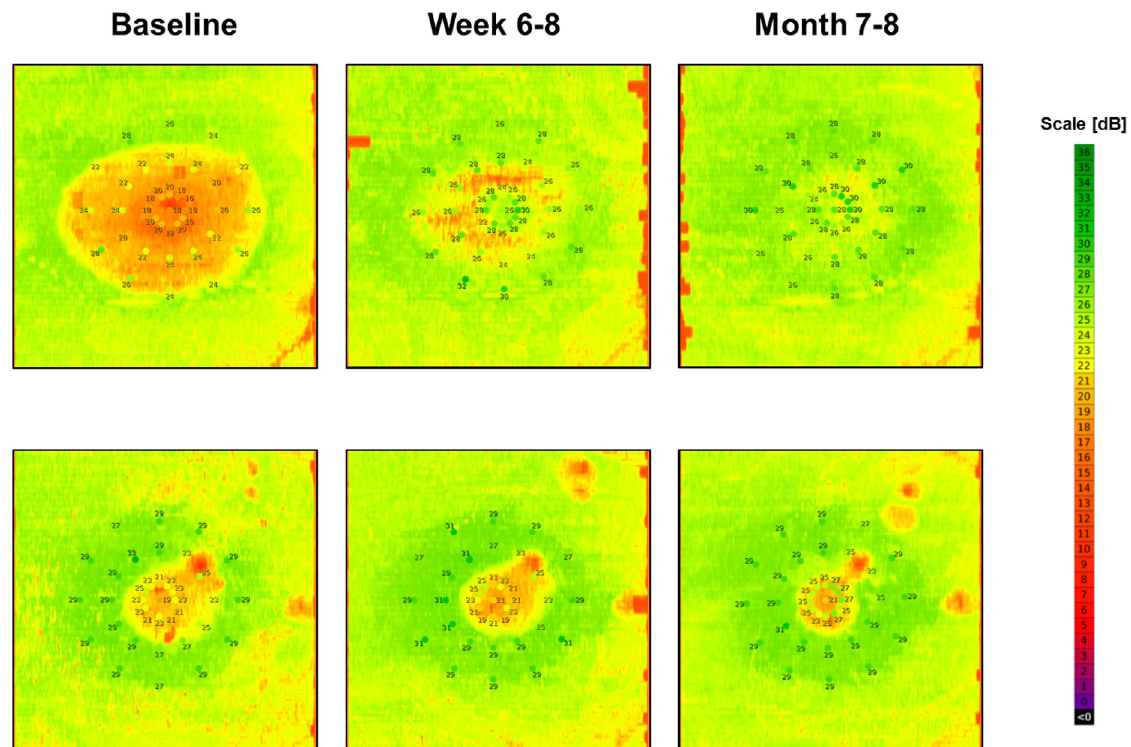
Figure 2. Examples of “inferred sensitivity mapping”. The plots show the cross-validated estimated retinal sensitivity (based on scenario 1) for 3 visits in 2 exemplary patients. The actual fundus-controlled perimetry results are overlayed. The color scale of the device manufacturer was applied for the mapping to facilitate comparisons. Overall, the estimated and observed sensitivity show marked correlation. However, the “inferred sensitivity” maps a superior spatial resolution and coverage of the posterior pole compared to the actual perimetry results. Notably, sensitivity can be estimated for loci between test-points as well as outside of the test pattern. However, the accuracy for predictions outside of the test pattern is